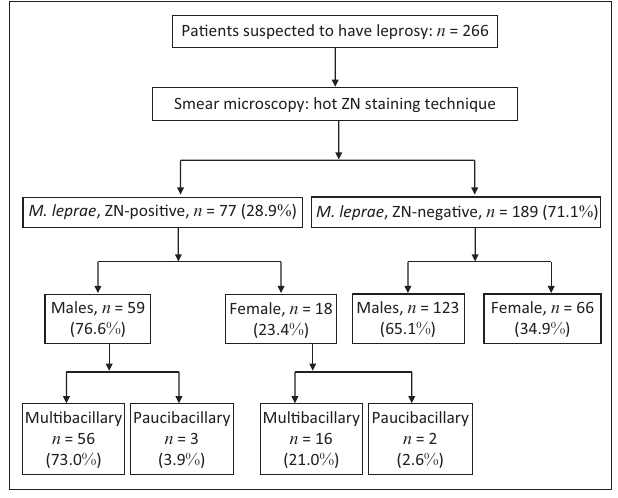
FIGURE 1: Results of enrolled patients for laboratory detection of Mycobacterium leprae , Rwanda,